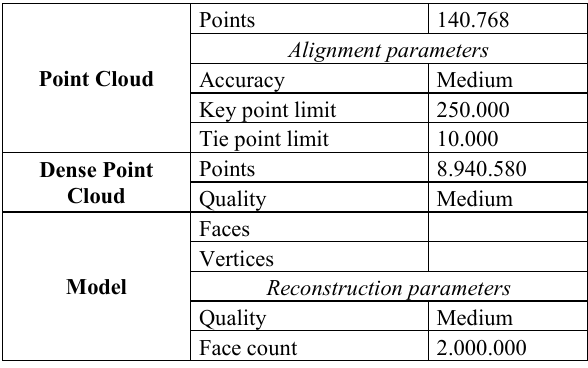
Table 1. Processing Parameters from PhotoScan Report -